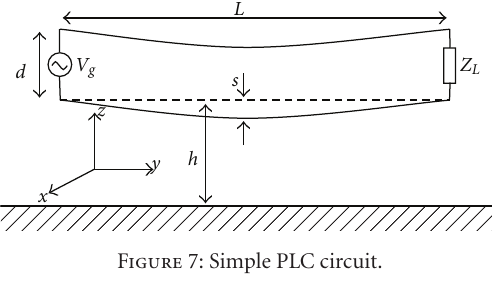
Figure 7: Simple PLC